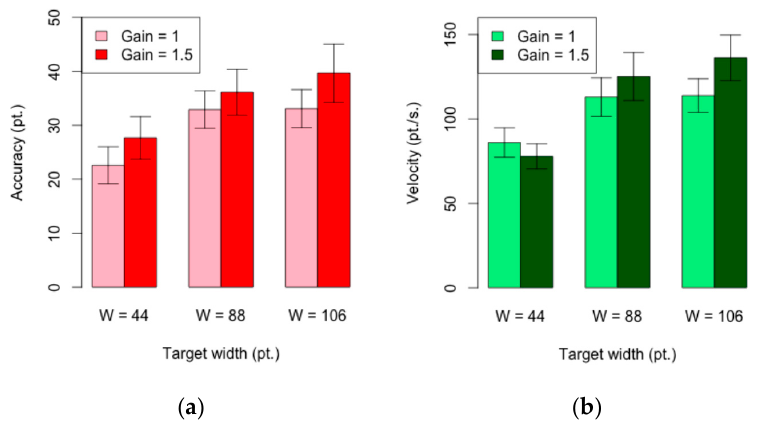
Figure 8. ( a ) Accuracy and ( b ) velocity by target width and gain. Error bars show 95% CI.